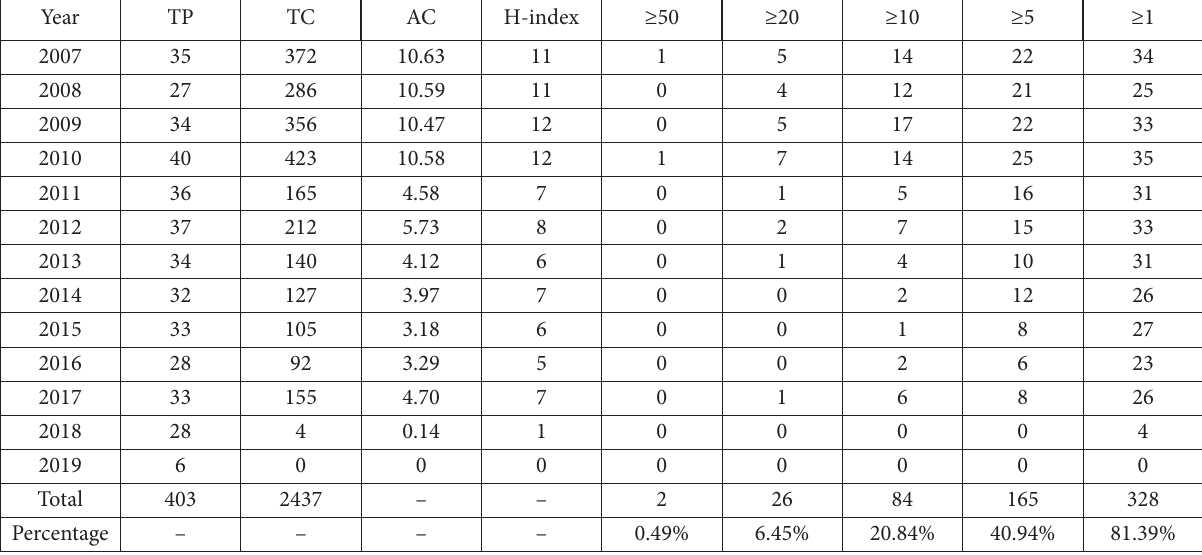
Table 2. JEELM publication characteristics between 2007 and